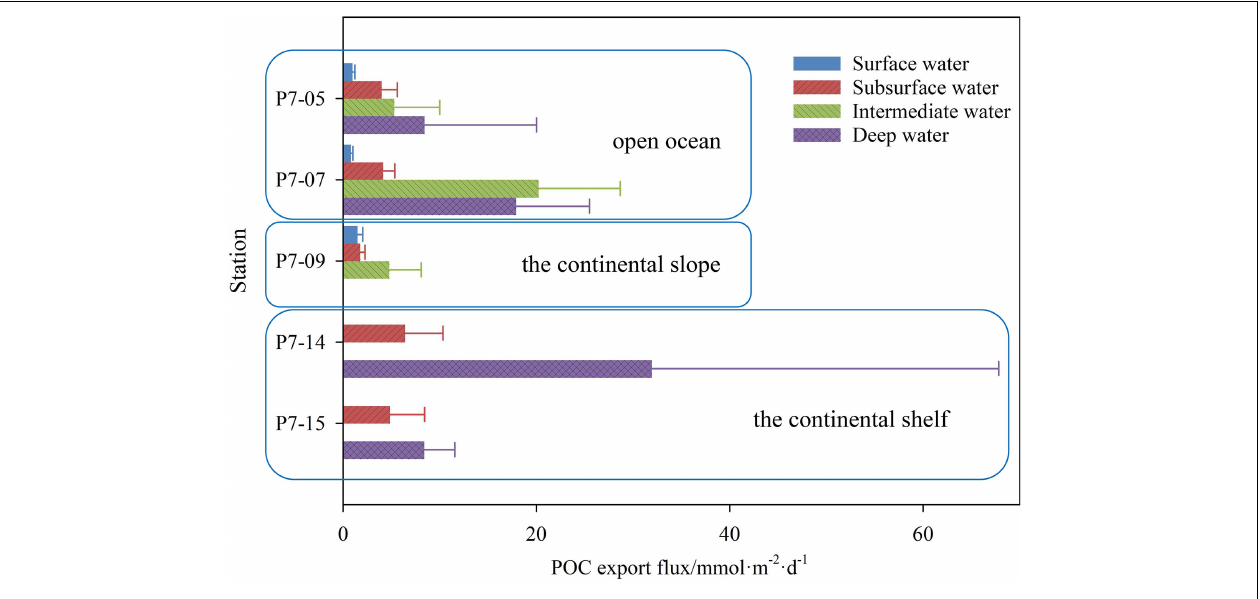
FIGURE 7 | The export flux of POC at different depth interface in the shelf, slope, and basin.